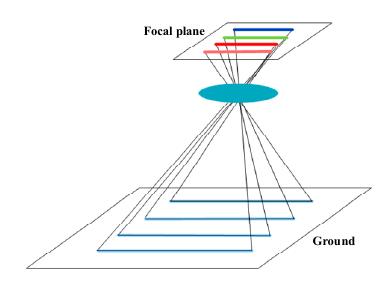
Figure 2. Schematic diagram of microvibration detection based on multispectral images [30]. (2) Microvibration detection based on the star map. Amberg [20] and Mo [30] successively